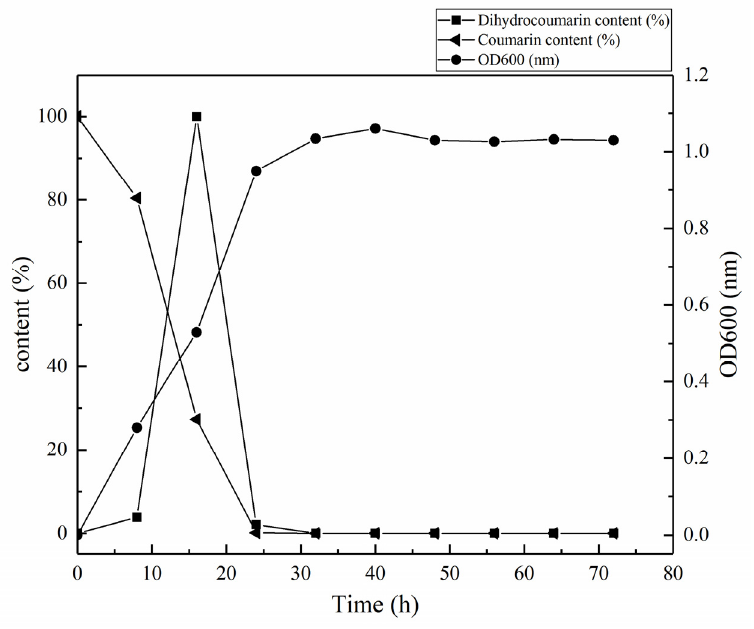
Figure 4. Growth curves of strain HSM-C2 and the content curves of coumarin and dihydrocouma- rin.